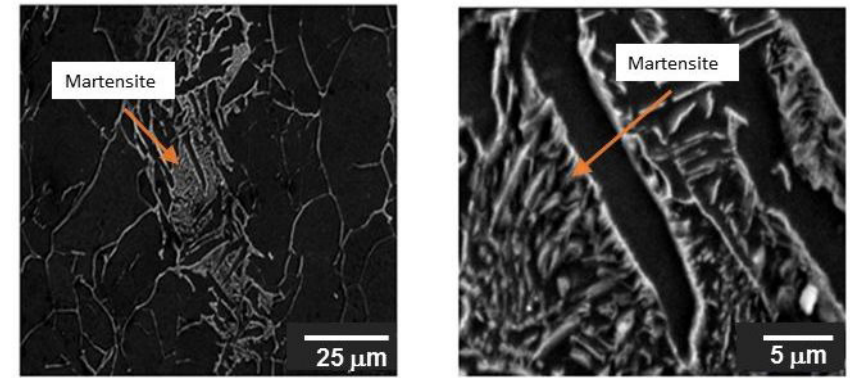
Figure 12. Microstructure of 1008 steel deformed at 800°C, 1000X and 4000X, strain rate 10 -2 s -1 . Martensite in a ferritic